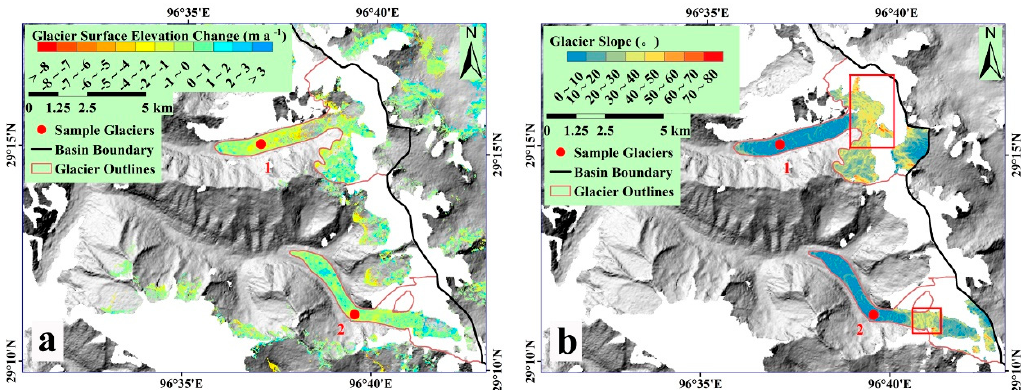
Figure 13. The glacier surface elevation change in 2000–2013 ( a ) and glacier surface slope ( b ) of the two sample glaciers (same with number 1 and 2 glaciers in the Figure 1b). Our reference DEM is SRTM DEM and the slope calculated by SRTM DEM using ArcMap 10.2 software approximately represents glacier surface slope in 2000–2013.